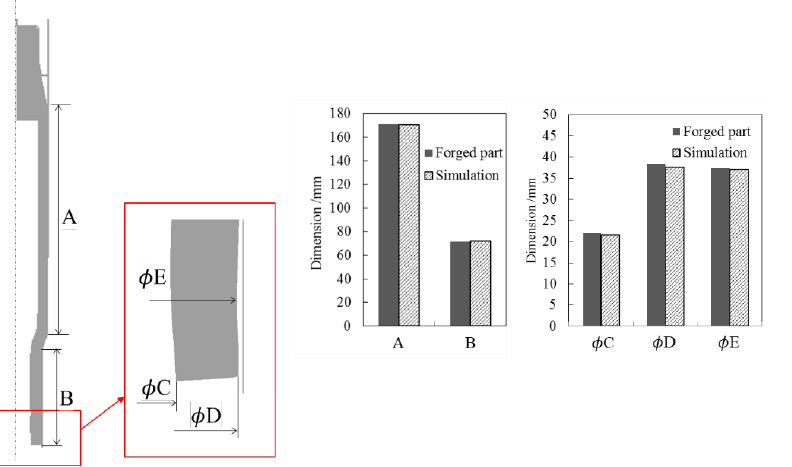
13 of 18 Figure 16. Flow curve of material of cold-forged hollow shaft S48C. Figure 17. The dimension of first forward extrusion and FEA model. Figure 18 shows the comparison of the dimensions A, B, 𝜙 C ~ 𝜙 E between the